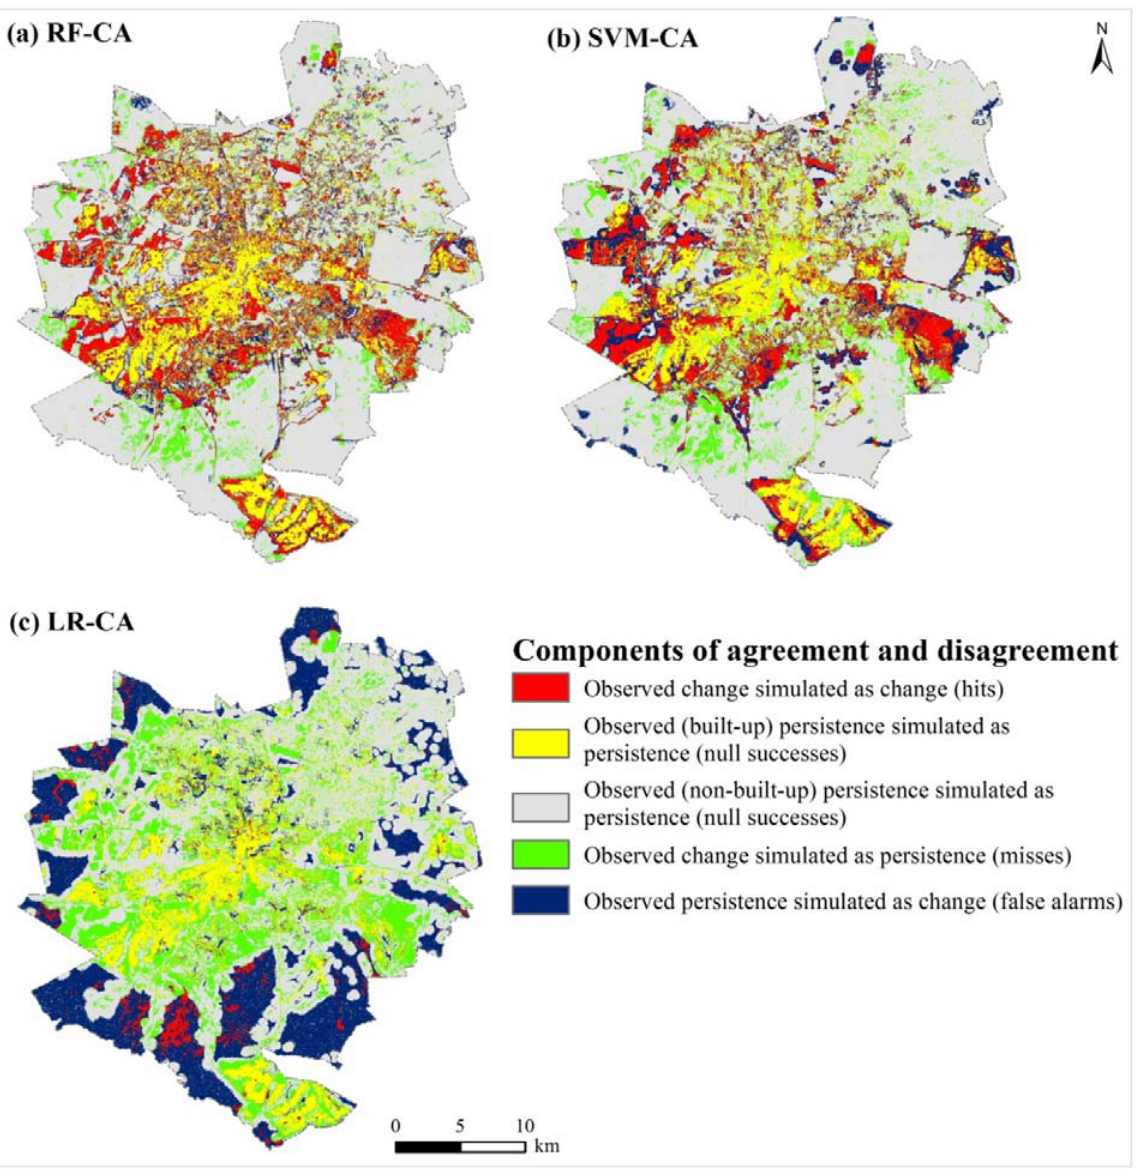
Figure 8. Components of agreement and disagreement for: ( a ) RF-CA simulated land use/cover map; ( b ) SVM-CA simulated land use/cover map; and ( c ) LR-CA simulated land use/cover